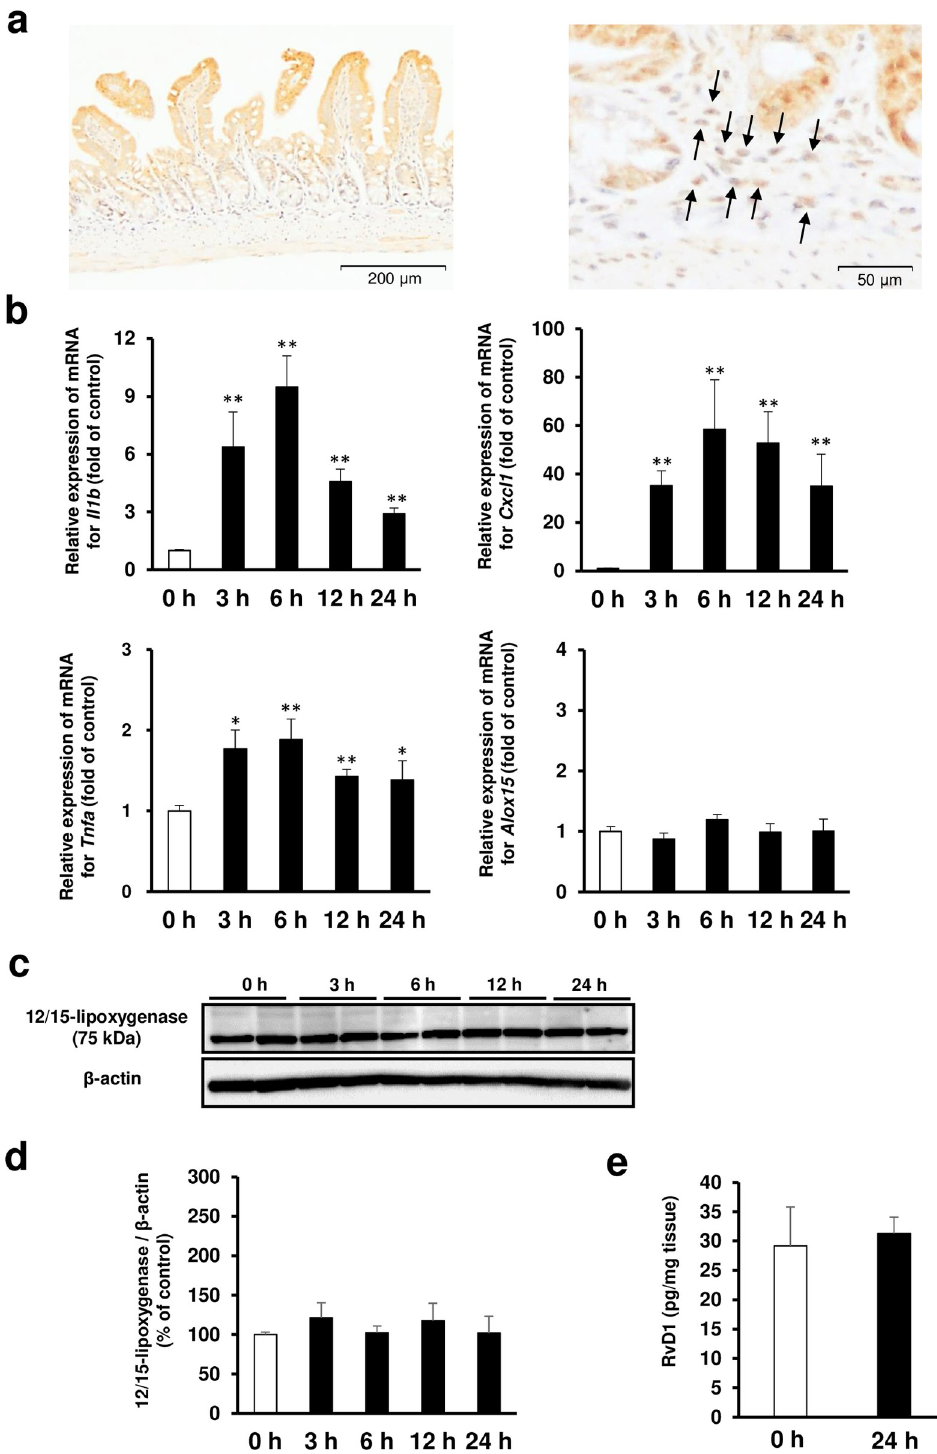
Fig 2. Dynamics and localization of 12/15-lipoxygenase in small intestinal tissue. (a) Representative image of immunohistochemical staining for localization analysis of 12/15-lipoxygenase protein in the small intestinal tissue. Bars in histological images: 200 μ m. The figure on the right is a magnified view showing inflammatory cells with arrows. Bars in histological images: 50 μ m. (b) Time course of gene expression levels of interleukin-1 β ( Il1b ), CXCL1/ keratinocyte chemoattractant ( Cxcl1 ), and tumor necrosis factor- α ( Tnfa ) and 12/15-lipoxygenase ( Alox15 ) after